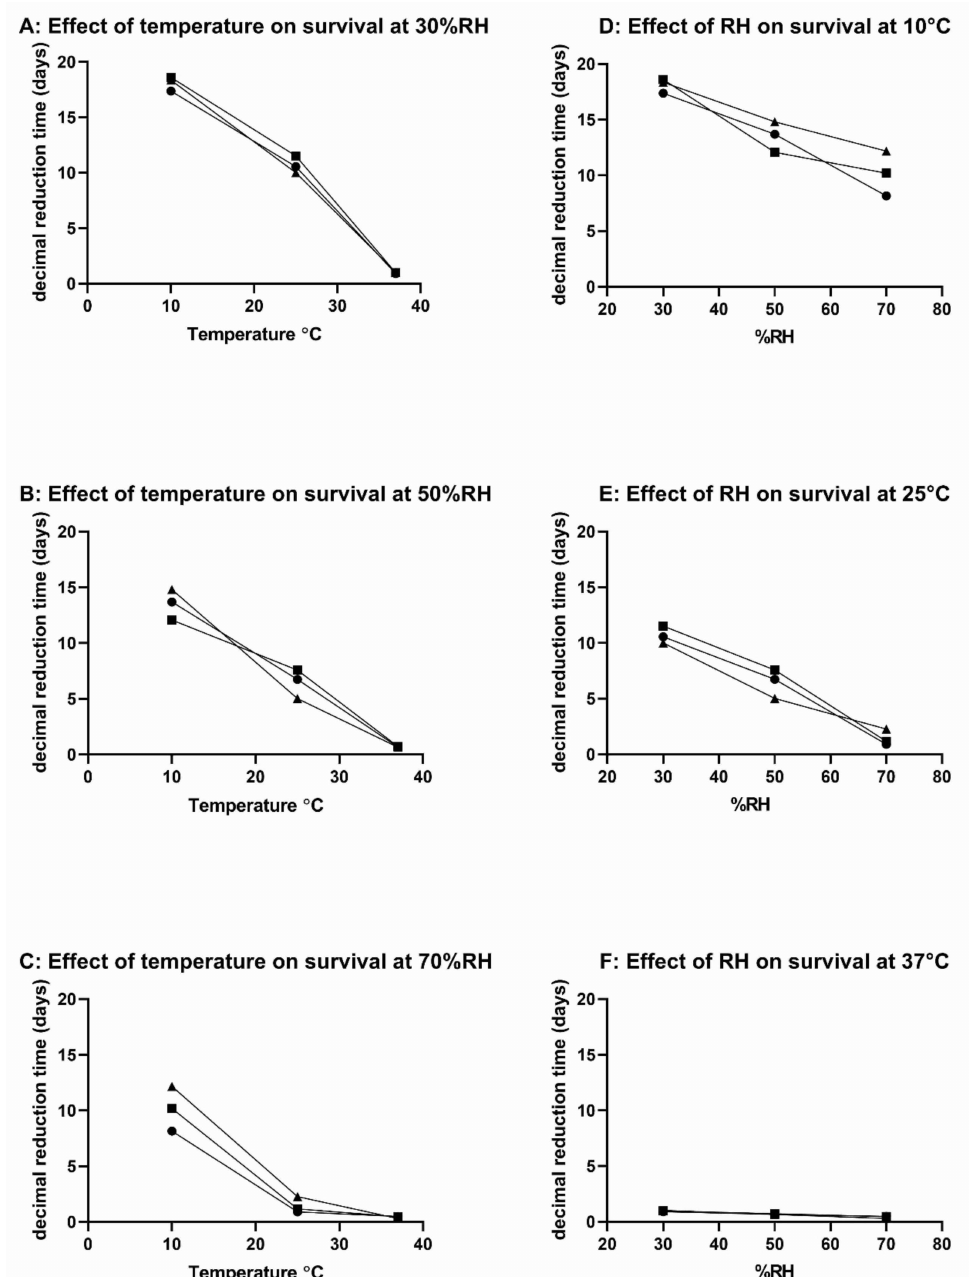
Figure 4. Effect of temperature ( A – C ) and RH ( D – F ) on survival of three serotype-matched S . Schwarzengrund isolates on stainless steel. Closed circles = clinical isolate; closed squares = factory isolate; closed triangles = veterinary